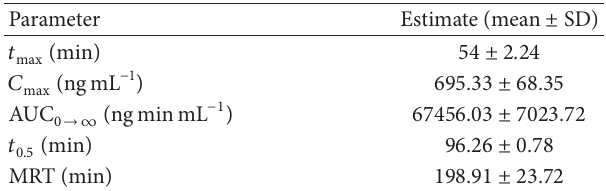
Table 4: Pharmacokinetic parameters of muscone in rat serum after oral administration of artificial musk (625 mg ⋅ kg −1 , 𝑛 = 6 ) ∗